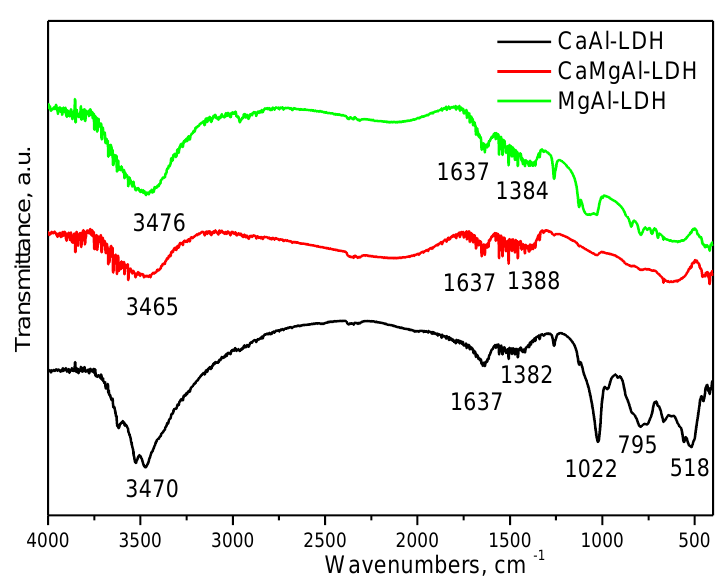
Figure 2. Fourier-transformed infrared spectroscopy of the prepared samples.